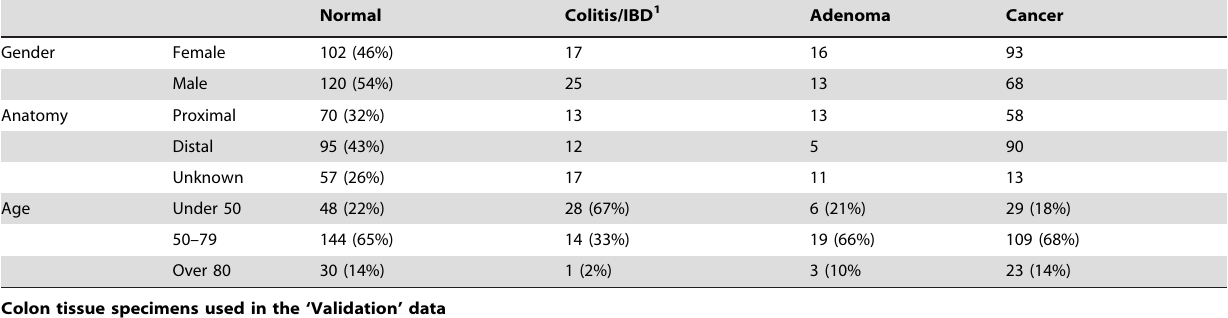
Colon tissue specimens used in the ‘Discovery’ data